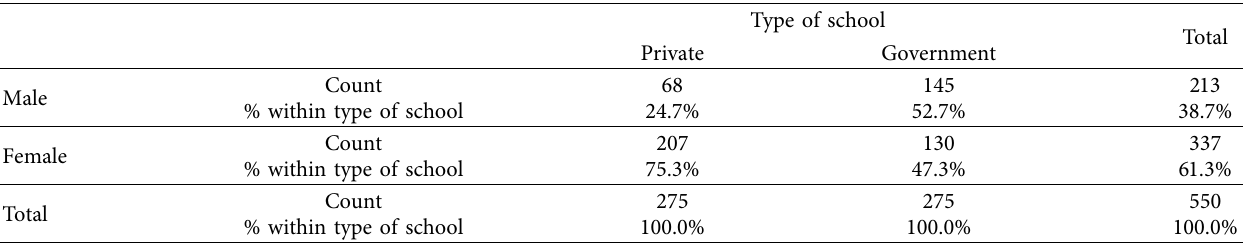
Table 2: Genderwise distribution of study population according to the type of school.